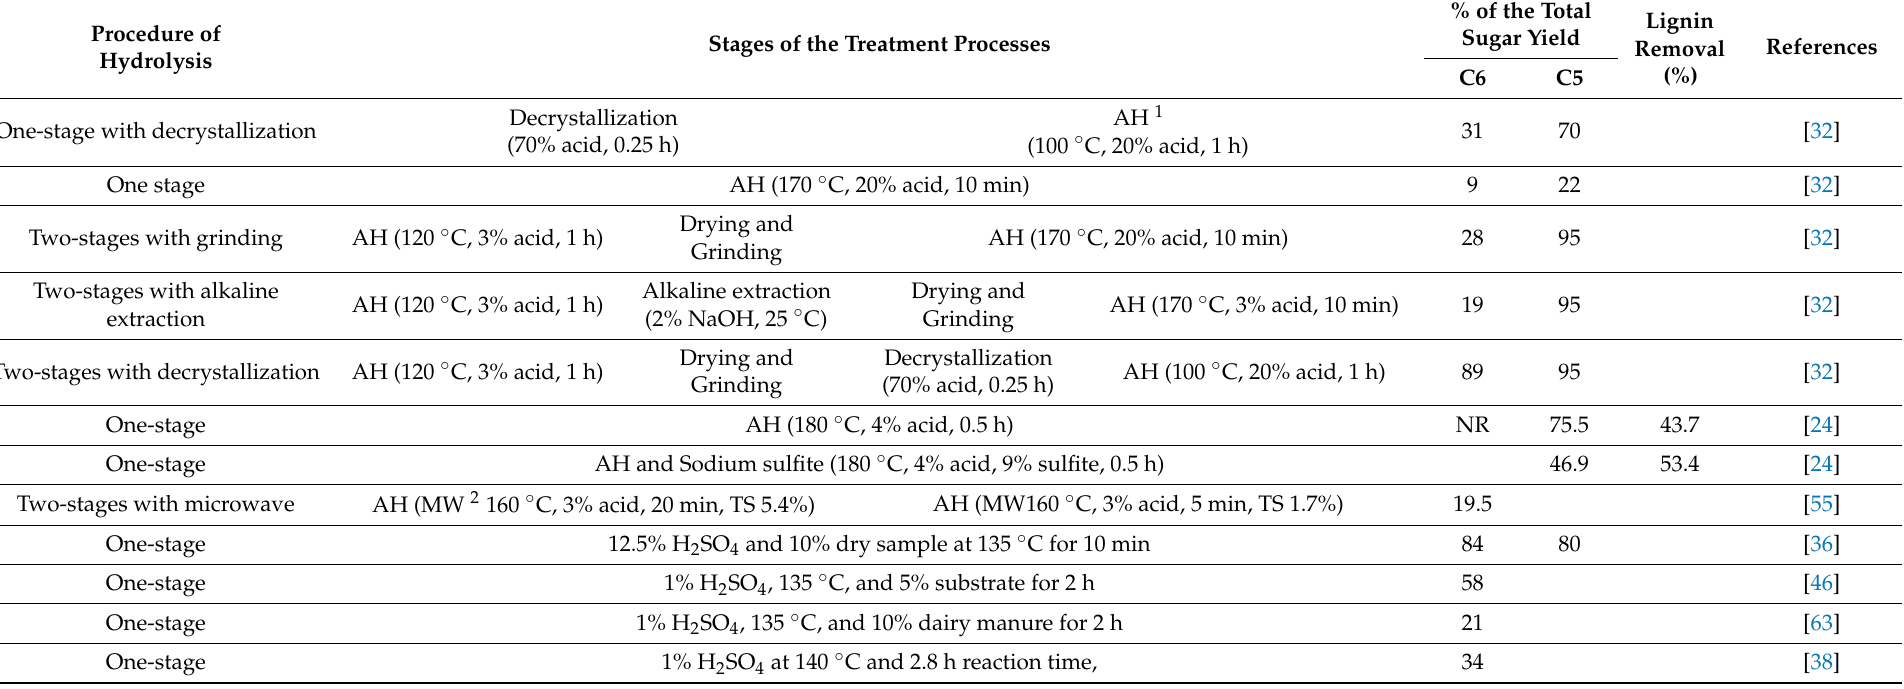
Table 3. Performance of different procedures for acid hydrolysis (AH) of dairy